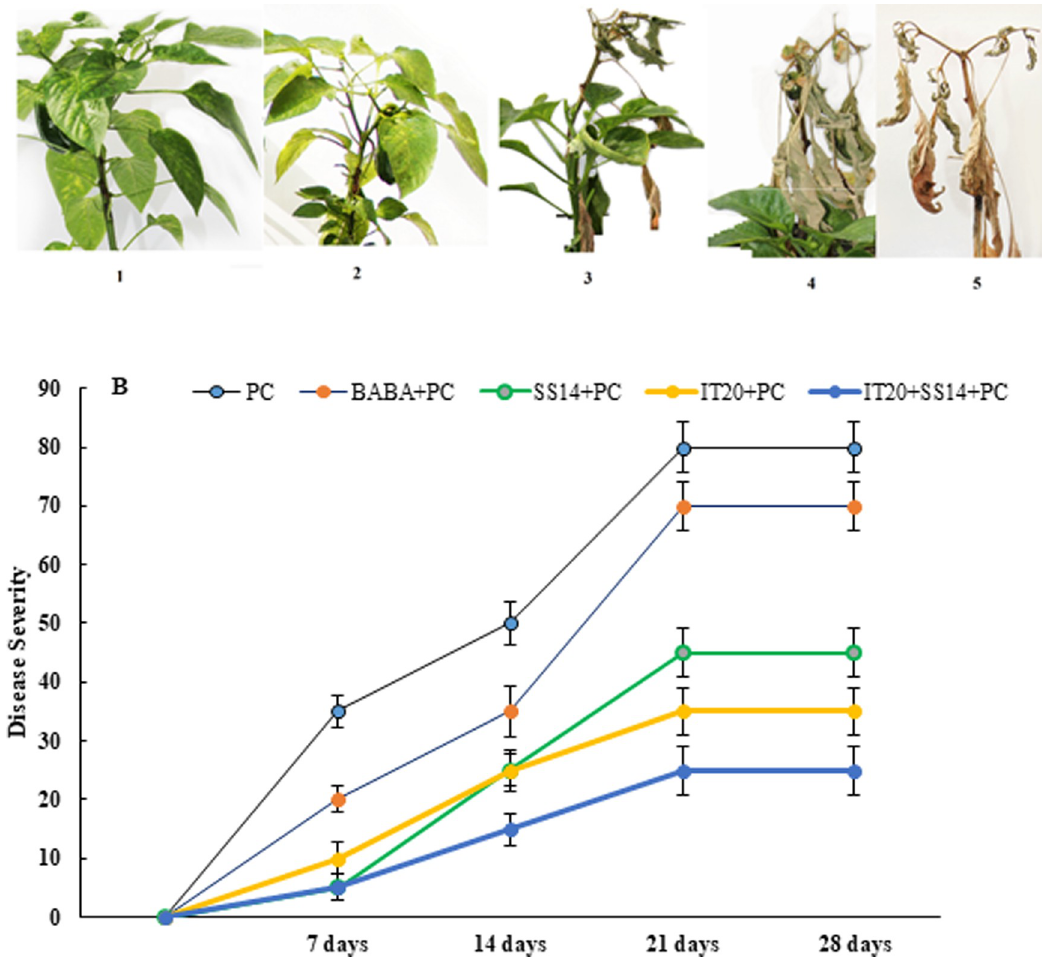
Fig 2. Disease scales ( A ) and disease progress ( B ) related to chemical (BABA), biological ( S . vinaceusdrappus SS14 or S . rochei IT20) and combination of biological treatments (IT20+SS14) from 7 to 28 days after inoculation of Phytophthora capsici ( PC ). plants (Fig 4C). In inoculated plants, there was no significant difference in transcripts of PR10 gene among single and combination treatments (Fig 4D). The results revealed that IT20+SS14 significantly up-regulate transcription factor (TF) WRKY40 expression by 33- and 22-fold compared to control and PC , respectively (Fig 4E). There was a 22- fold up-regulation in the transcription of WRKY53 in BABA-treated plants after pathogen inoculation (Fig 4F). Tran- scripts of ET- response factor ( ERF ) significantly increased (50-fold) in PC at seven dai (Fig 4G). IT20+SS14 significantly induced transcripts ERF gene by 37-fold compared to control, BABA and single treatments. In inoculated plants, the results revealed that IT20+SS14 signifi- cantly up-regulated (six-fold) the expression of ERF compared to IT20 and SS14 (Fig 4G). IT20+SS14 significantly induced a 50-fold up-regulation in ACCO (1-aminocyclopropane- 1-carboxylic acid (ACC) oxidase) transcripts compared to control. Pathogen inoculation sig- nificantly suppressed transcripts of ACCO (Fig 4H). In fruit tissues, transcripts of GST signifi- cantly were suppressed in all treatments and the maximum relative ratio was associated with IT20+SS14 treatment. The transcripts of GST significantly increased in inoculated treatment of IT20. The most suppression of GST expression was observed in PC (Fig 5A). The transcript